Question: Provide a publication-style caption for this figure.
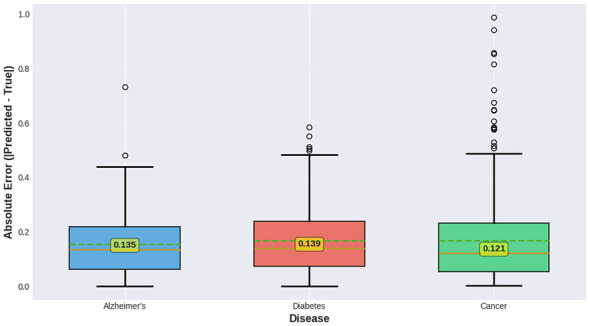
Answer: Absolute error distribution across diseases.